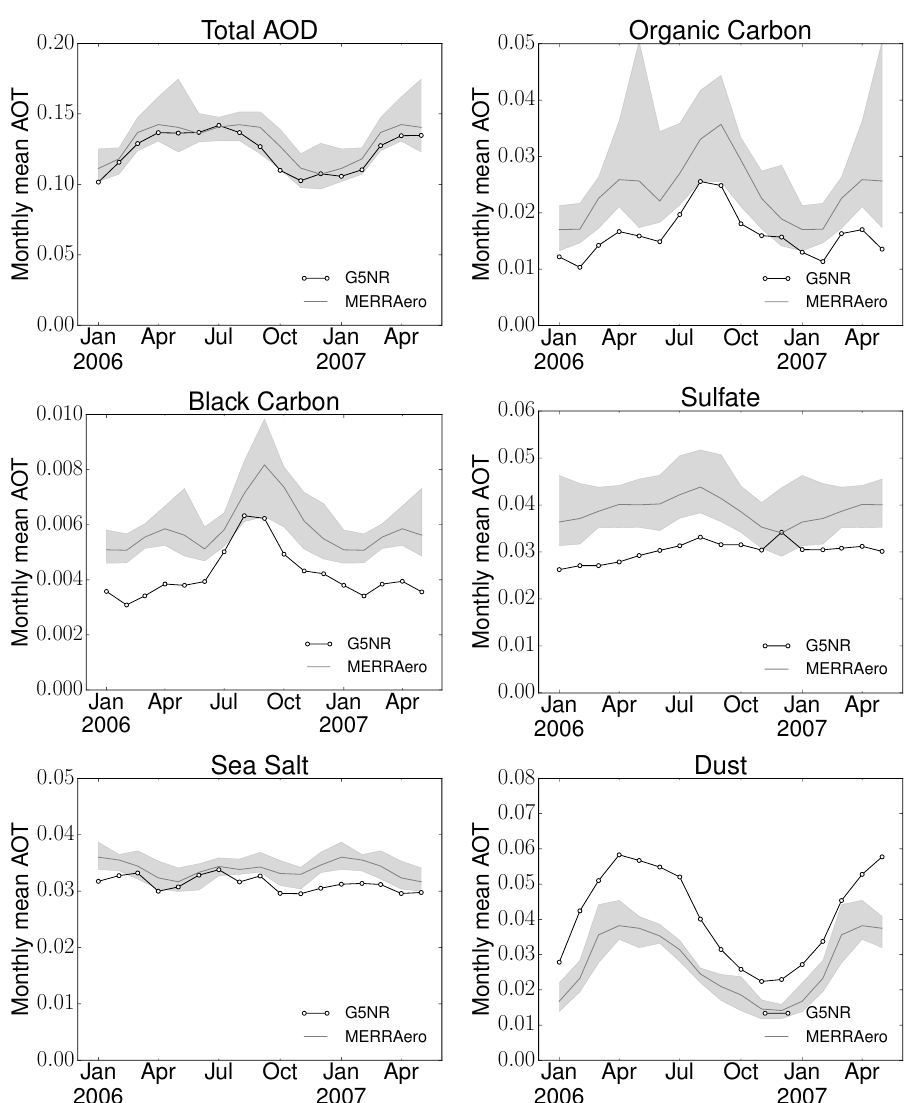
Figure 4. Time series of global monthly mean 550 nm AOD. Results from the G5NR simulation are in black. The monthly mean climatology from the MERRAero reanalysis is shown in gray; the shaded area encloses the minimum and maximum monthly means from the 14-year time series (2002–2016), while the gray line represents the